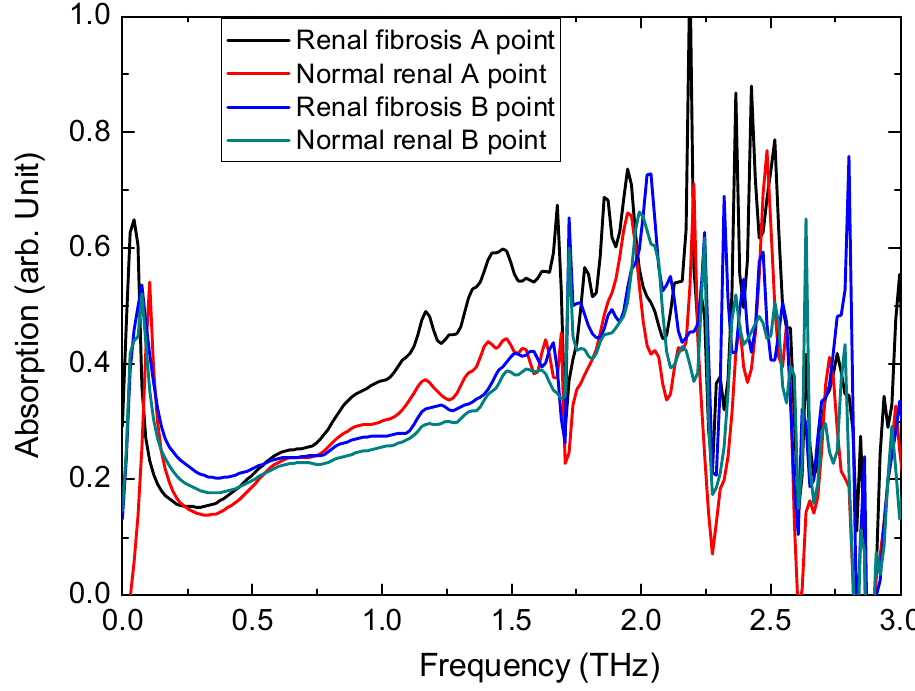
Figure 3. THz absorption spectra of mouse renal tissues in normal and renal fibrosis group. Black line is the absorption spectrum of the renal fibrosis tissue from the renal fibrosis group (center point). Blue line is the absorption spectrum of the renal fibrosis tissue from the renal fibrosis group (edge point). Red line is the absorption spectrum of the normal renal tissue from the normal group (center point). Green line is the absorption spectrum of the normal renal tissue from the normal group (edge point).